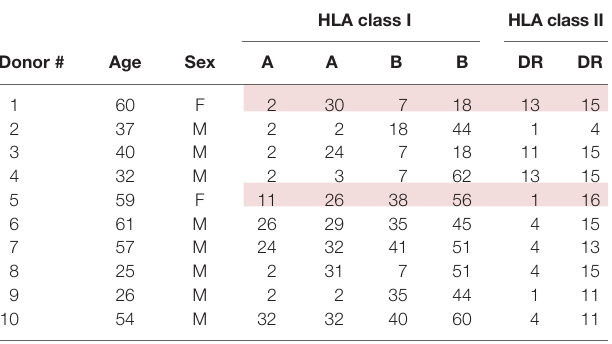
TaBle 1 | De-identified tissue donor data including human leukocyte antigen (HLA) markers A, B, and DR for both